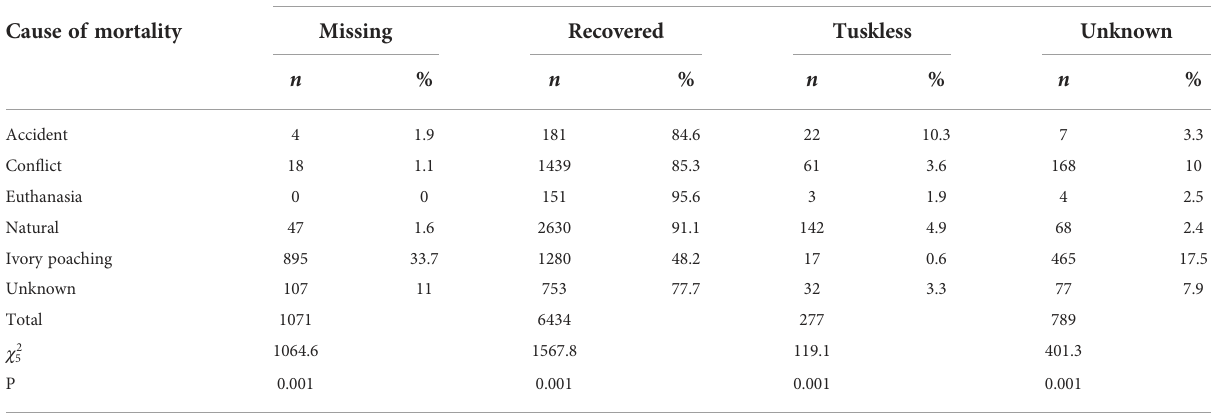
TABLE 5 Elephant tusk recovery status by cause of mortality in Kenya during